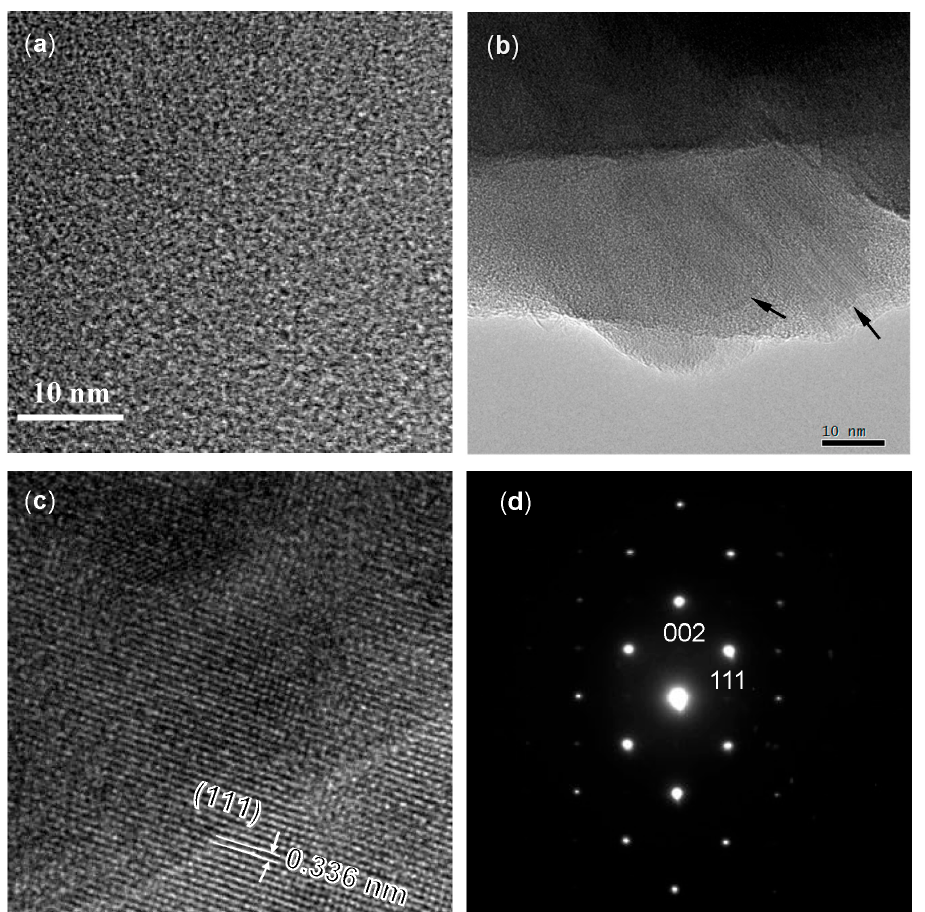
Figure 10. Typical TEM images showing ( a ) X-ray amorphous Si-O-N after heat treatment at 1400 °C; ( b ) nanocrystallites (indicated by arrows) formed in-situ within the amorphous matrix by heating to 1600 °C; ( c ) high resolution TEM (HRTEM) image; and, ( d ) selected area electron diffraction (SAEDP) obtained for the nanocrystallite shown in ( b ).